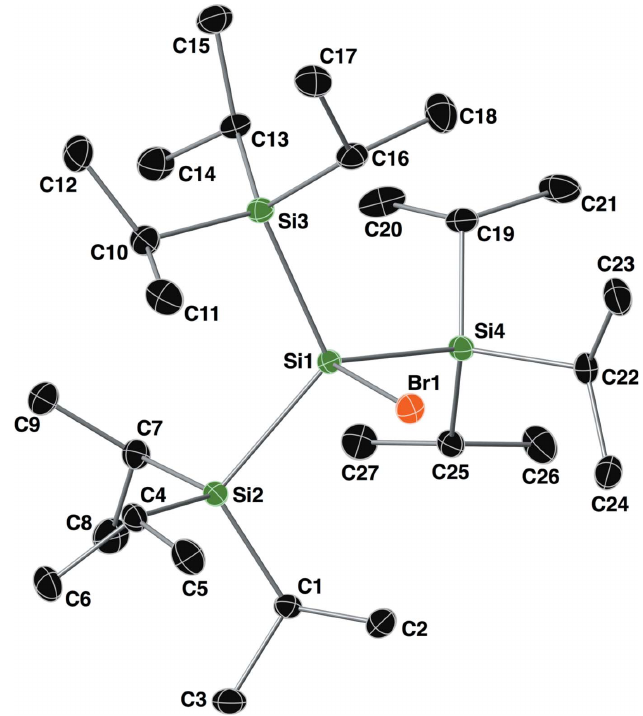
Figure 1 A view of the molecular structure of compound I , with atom labelling. Displacement ellipsoids are drawn at the 30% probability level. Hydrogen atoms have been omitted for clarity. Unlabelled atoms are related to the labelled atoms by threefold rotation symmetry [symmetry codes: (i) z , x , y ; (ii) y , z , x